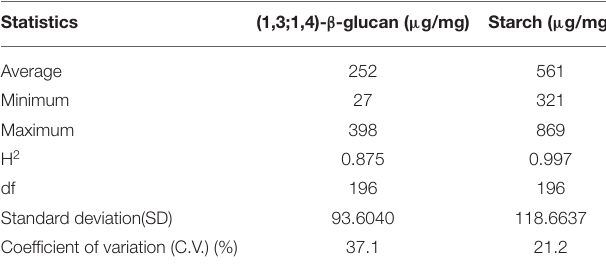
TABLE 1 | Descriptive statistics for mixed linkage (1,3;1,4)- β -glucan (MLG) and starch content.